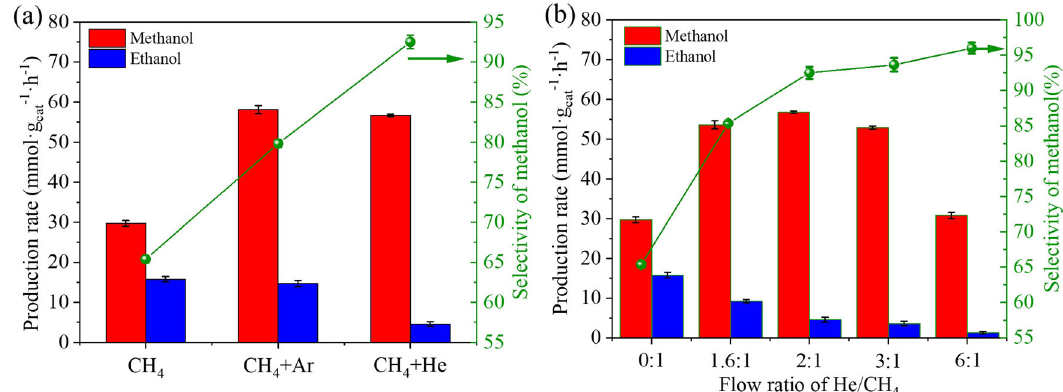
Fig. 6 Alcohol formation rate and methanol selectivity. a Effect of the addition of He or Ar on the reaction at total fl ow rate of 15 mL min − 1 . b Effect of the He/CH 4 feed ratio on the reaction at CH 4 fl ow rate 5 mL min − 1 (discharge power of 30 W, ca. 5 mg TiO 2 -700 catalyst, error bars obtained from repeated three sets of experiments on the same catalyst). Table 1 Comparison of methanol production rates obtained in this study and in previous studies.